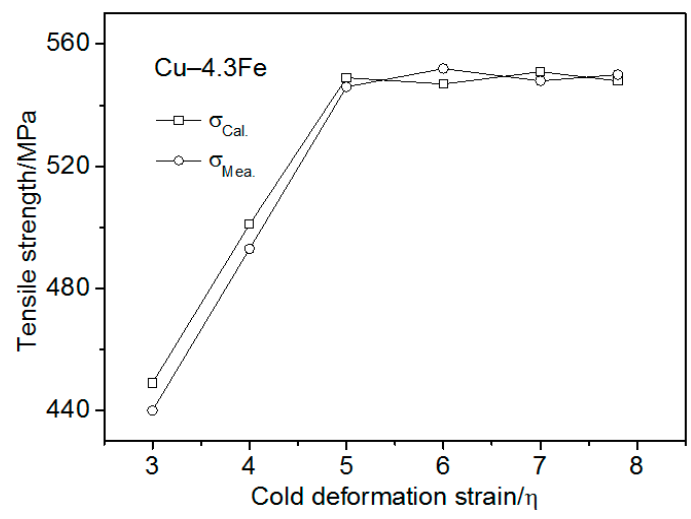
Figure 8. Measured and calculated tensile strength of Cu–4.3Fe vs. the cold deformation strain.